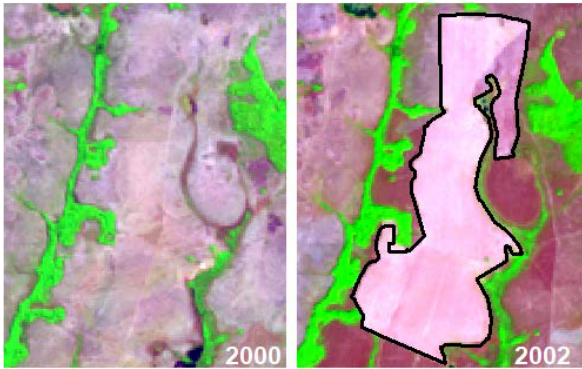
Figure 4 – Example of bare soil detection distinguished due to anthropic vegetation removal revealed between 2000 and 2002. Bare soil feature is surrounded by herbaceous vegetation (darker magenta) and shrub lands (green tones).